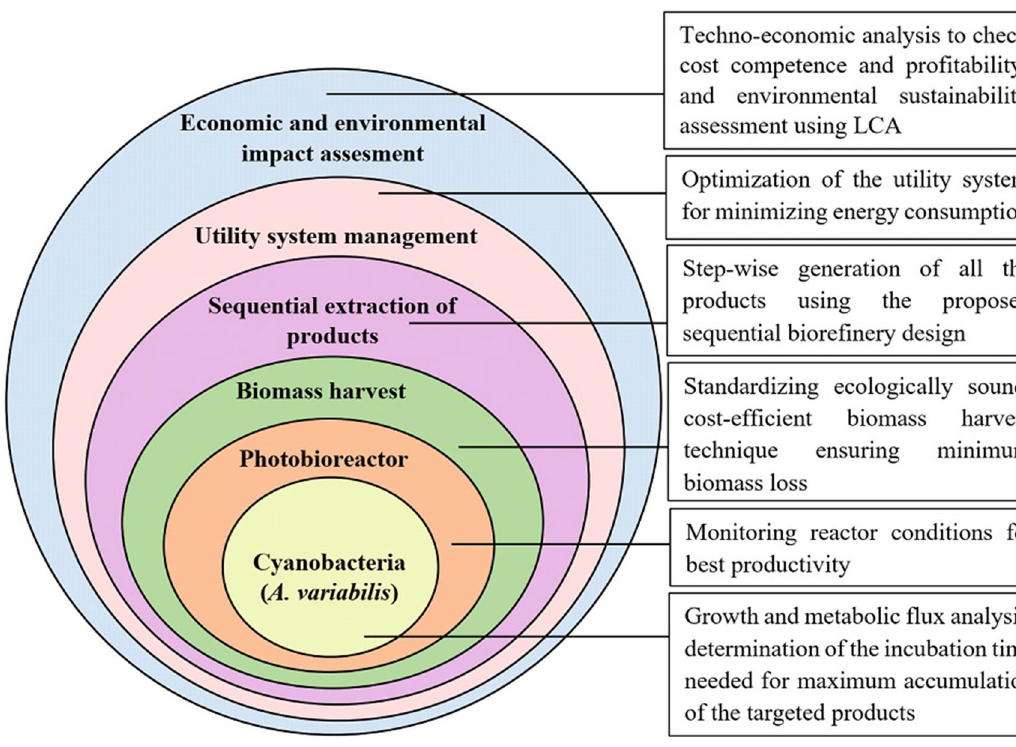
Figure 6. Onion model for the cyanobacterial refinery with each level assigned to specific